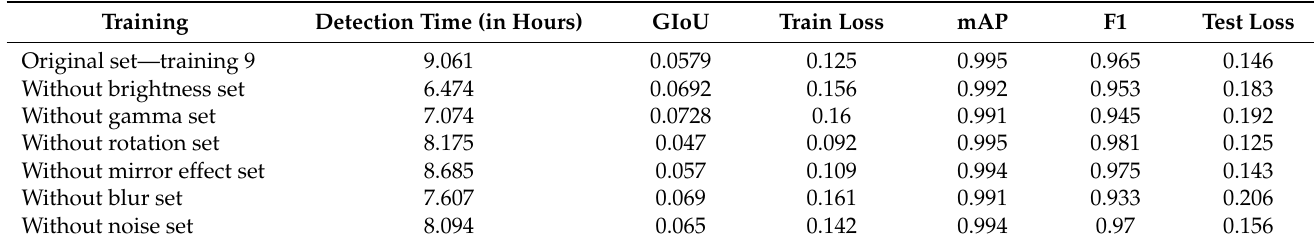
Table 4. Summarized results for effects of other applied augmentation techniques.